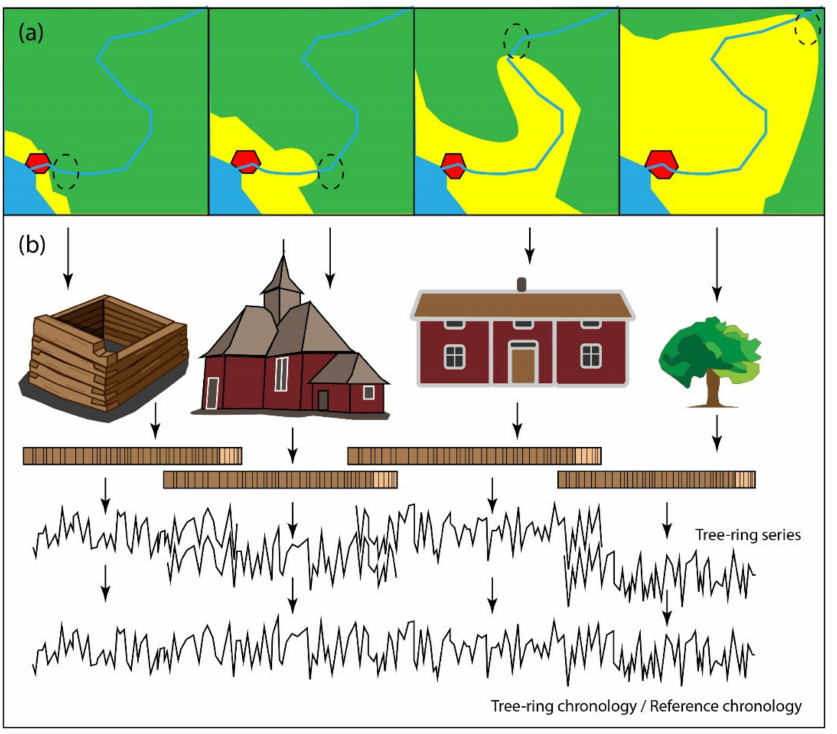
Figure 2. ( a ) The source area for the timber (dashed circle) is gradually moved away from the city (the red marking) when the forest (green area) is replaced by arable land (yellow area), which means that the provenance of the timber has changed as the surroundings were deforested. ( b ) A tree-ring chronology can be developed from tree-ring series from living trees and historical timber that are averaged into a tree-ring